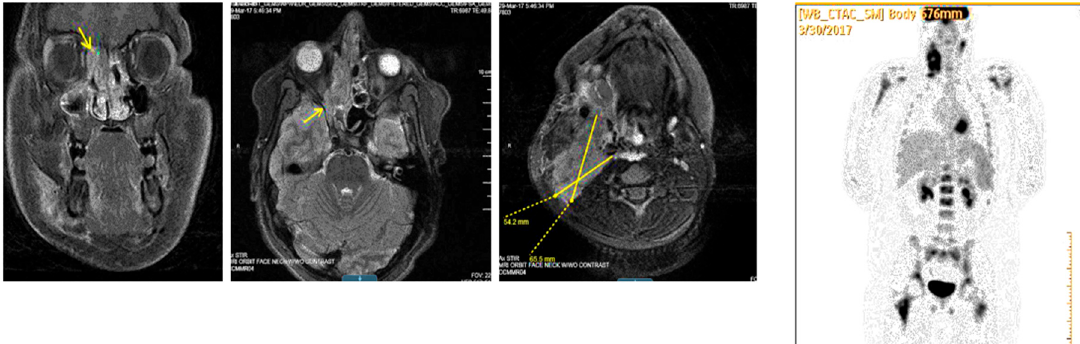
Figure 7. MRI T-1 weighted image of 13 y/o patient with Stage IV parameningeal alveolar RMS. ( Left ) image shows in a coronal plane a heterogeneous mass centered within the right ethmoid air cells (arrow) and superior nasal cavity mildly displacing the orbit. ( Right ) image—axial cut shows right neck lymphadenopathy shown as well with high uptake in PET scan image at the far right.